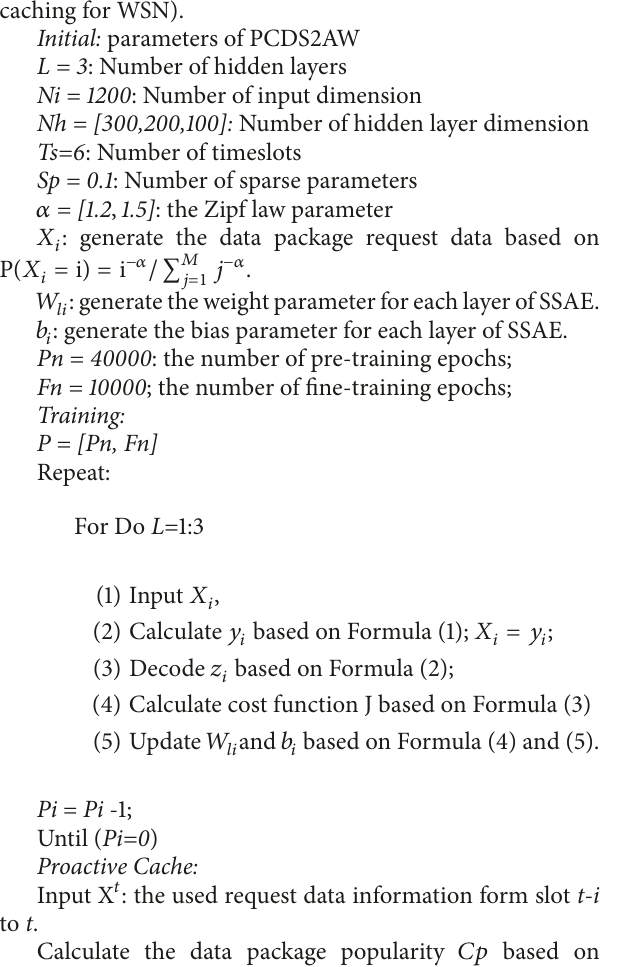
Algorithm 1 (the implementation of PCDS2AW for proactive caching for